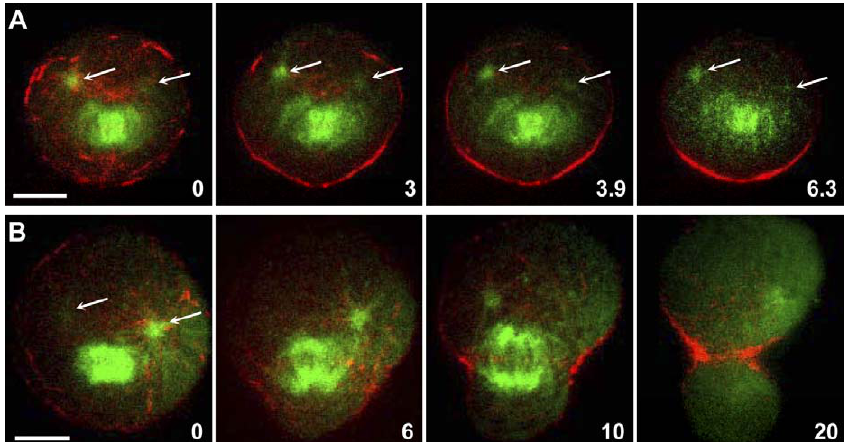
Figure 2. Cortical Actin Filaments Were Excluded from the Polar Cortex Bordering the Asymmetrically Distributed Asters (A) Both asters (arrows) were naturally positioned at the upper pole of the spindle. Cortical actin filaments flowed towards the lower polar cortex during early anaphase. Cells in Figure 2 were labeled as in Figure 1B. Time 0 depicts anaphase onset. (B) Cortical actin filaments, excluded by asymmetrically distributed asters (arrows), assembled a contractile ring around the equator of the naturally shifted spindle. Actin aggregates were also present by later anaphase. Time in min. Time 0, anaphase onset. Bars, 10 l m.